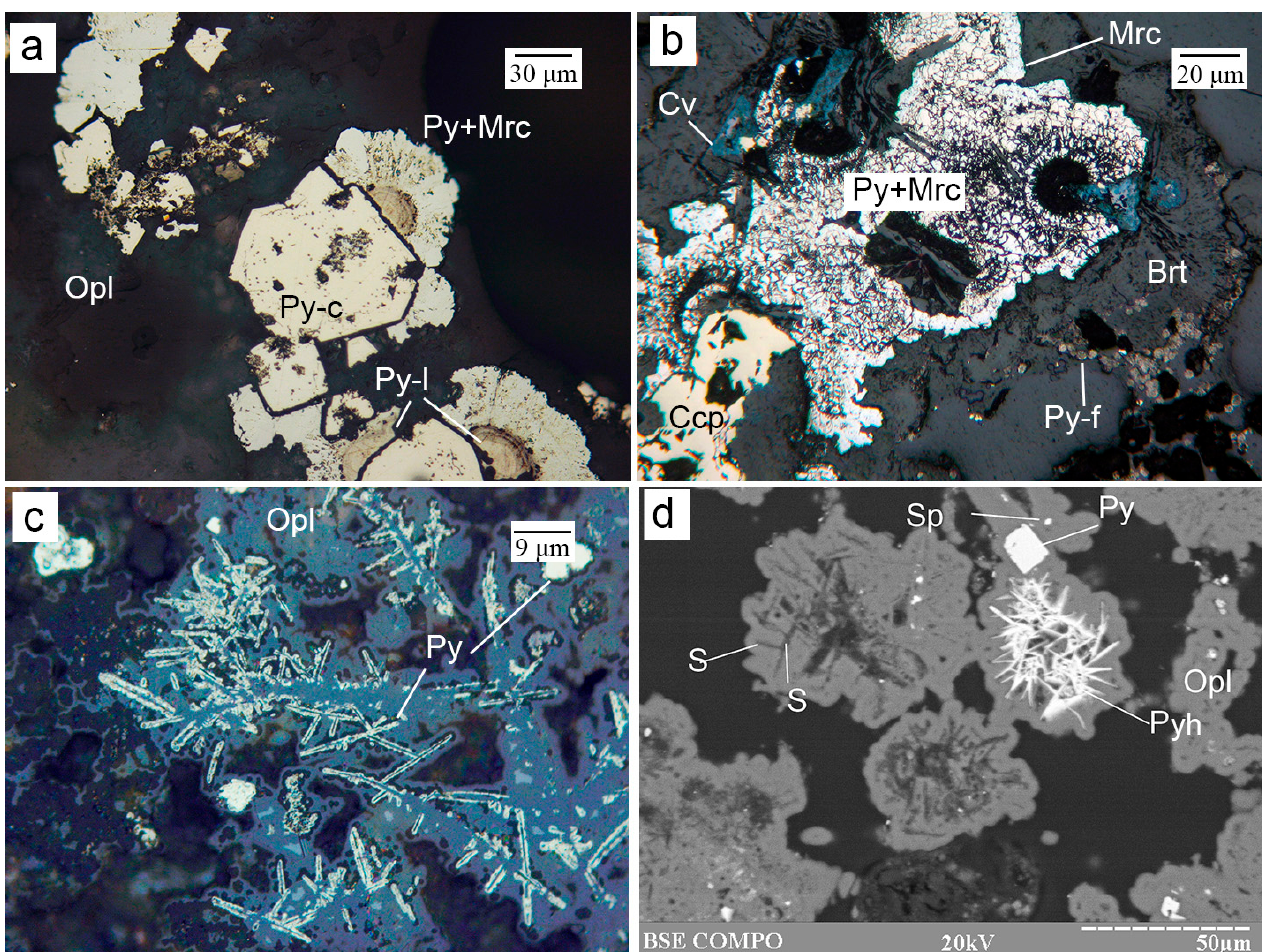
Figure 6. Morphology of Fe sulfides from the Irinovskoe HSF: ( a ) Crystalline pyrite (Py-c) overgrown by reniform pyrite composed of the laminar core (Py-l) and radial pyrite–marcasite rim (Py+Mrc) in opal; ( b ) Crystalline pyrite–marcasite aggregate (Py+Mrc) with a marcasite rim overgrown by baryte (Brt) and framboidal pyrite (Py-f); ( c ) Opal filaments overgrown by fine-crystalline pyrite; ( d ) Lattice aggregates of acicular pyrrhotite and native sulfur (S), crystalline pyrite and sphalerite grains in opal. Images: a–c , reflected light; d , BSE image. Sample numbers: 241-2/2-2 ( a , d ), 241-2/4-1 ( b ); 241-2/2-5 ( c ).